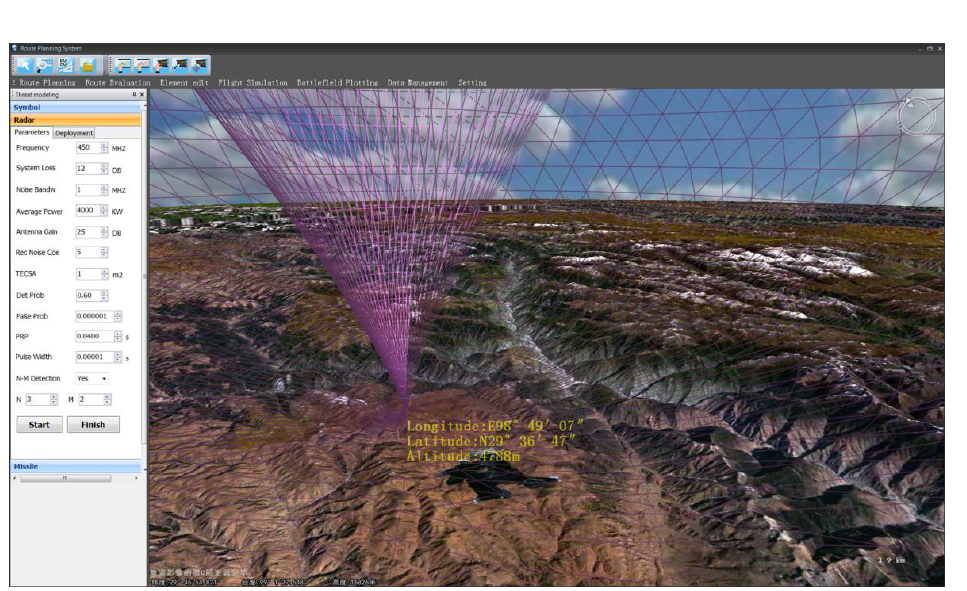
Figure A1. Threat modelling in the route planning system in which a radar threat zone is marked Figure A1. interactively.